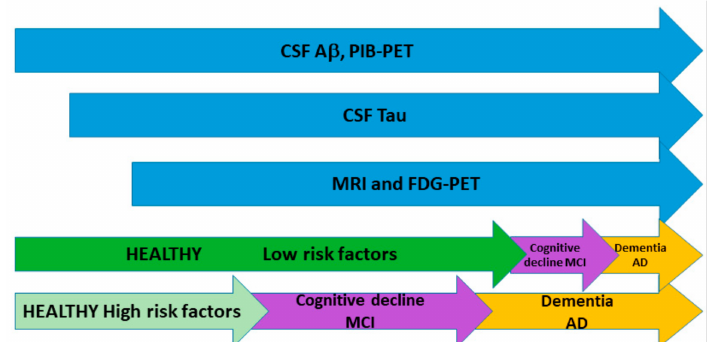
Figure 1. Evolution of the di ff erent AD biomarkers along time. Cerebrospinal fluid (CSF) A β and Pittsburgh compound B positron emission tomography (PiB-PET) abnormalities appear first followed